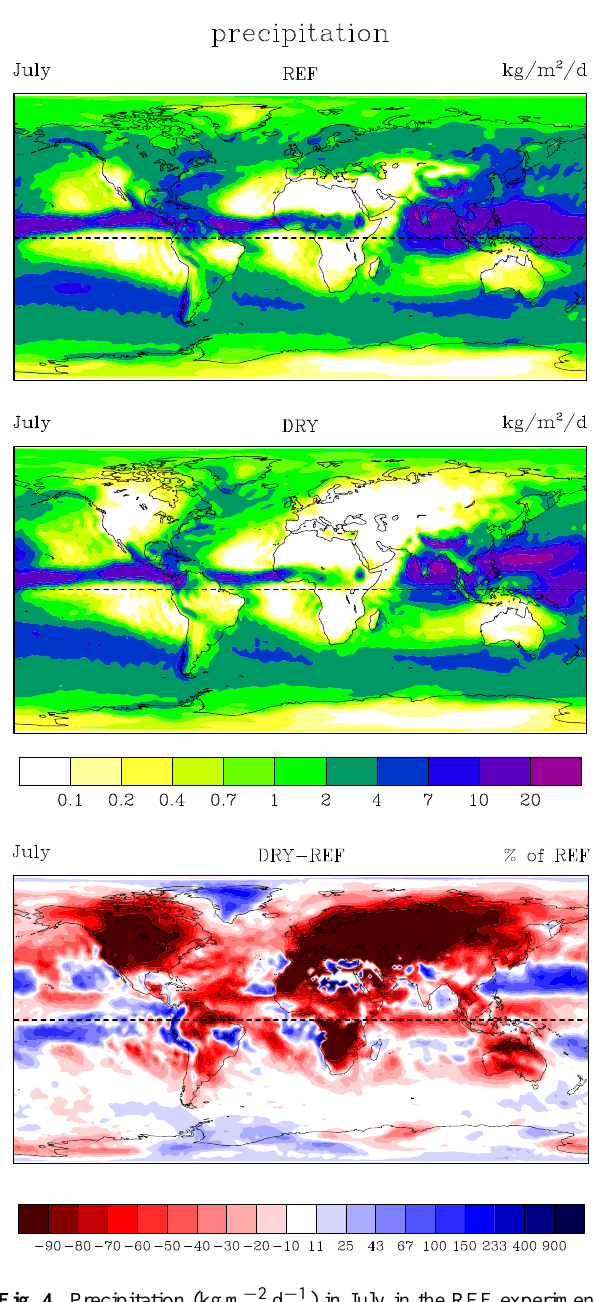
Fig. 4. Precipitation (kgm − 2 d − 1 ) in July in the REF experiment (top panel), in the DRY experiment (middle panel), and the differ- ence between the two (bottom panel, %). Note that the red part of the colour scale of the difference plot is kept identical to the one used in Fig. 2 to allow for direct comparison. The values of the blue part of the colour scale of the difference plot equate to (10%, 20%, ..., 90%) in relation to the DRY experiment. See Fig. S3 in the Supplement for